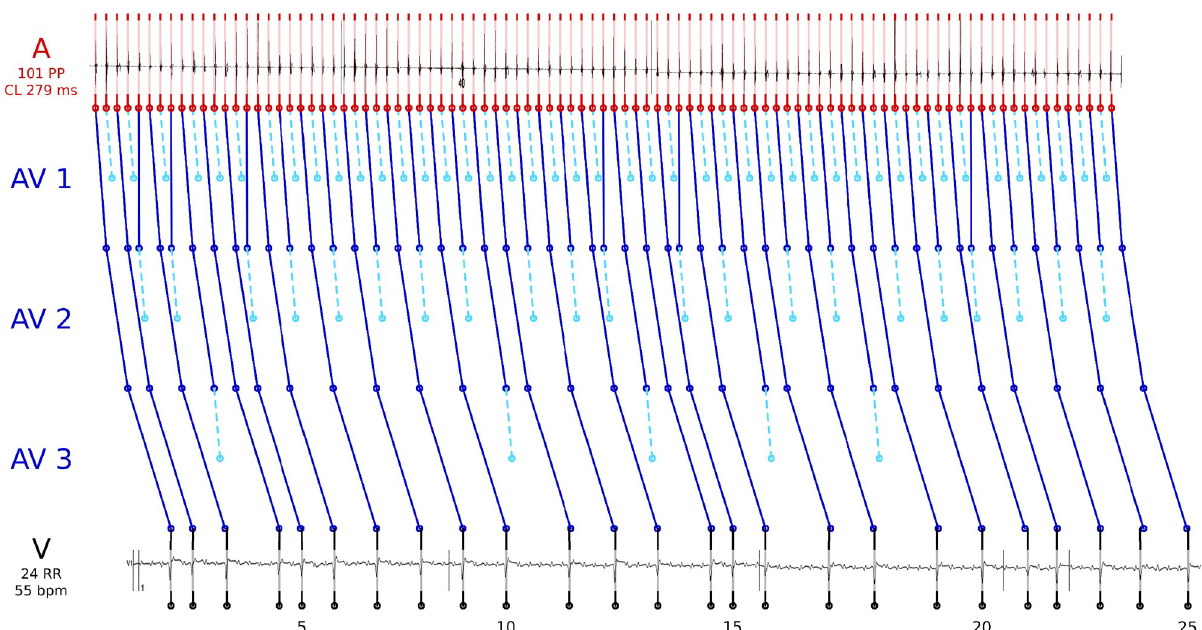
Fig 5. Exemplary illustration of how the feature blocktype derived from a HEAT solution can be a posteriori pathophysiologically interpreted and used.